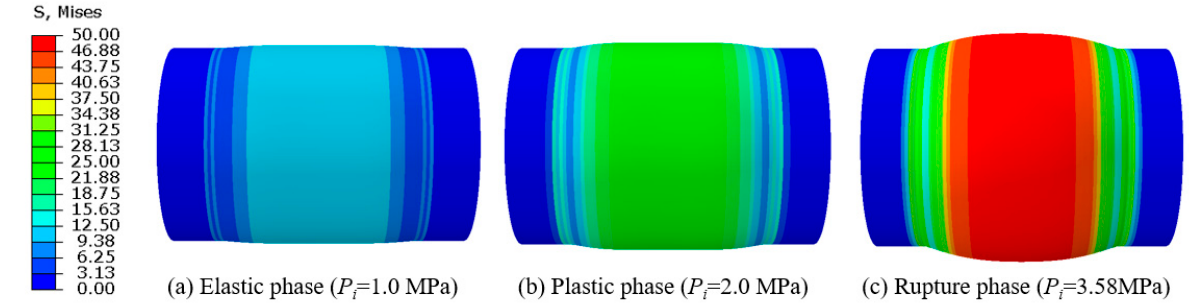
Figure 18. Von Mises stress distribution during pressurization (P1200-1).